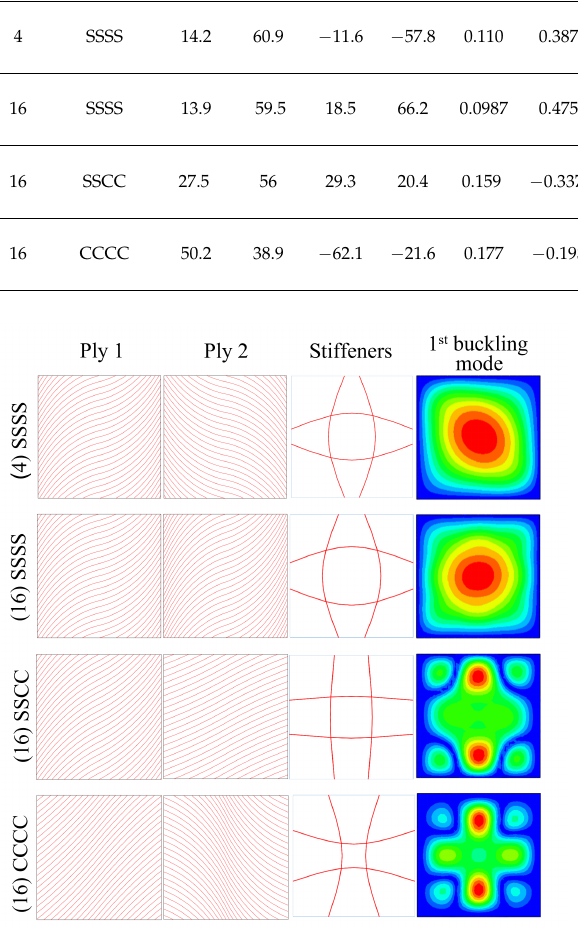
Table 5. Optimization results of ideal panels subjected to a biaxial compression load. Total Plies